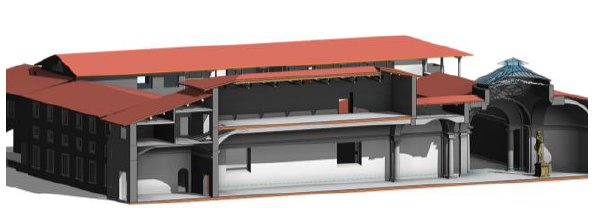
Figure 1. Cross section of the Building Information